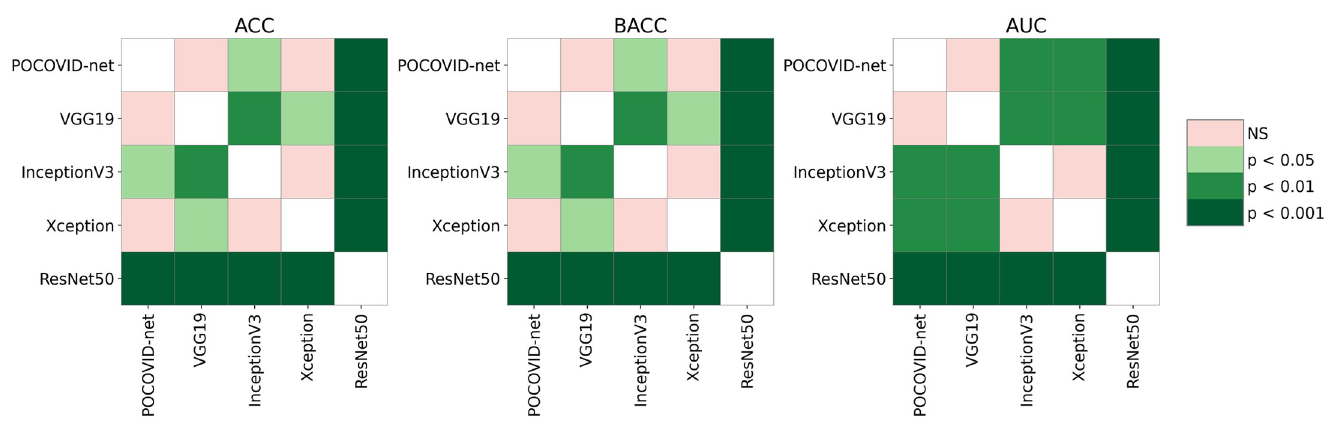
Fig 7. Post-hoc pairwise comparison using the Wilcoxon signed-rank test with Holm correction.